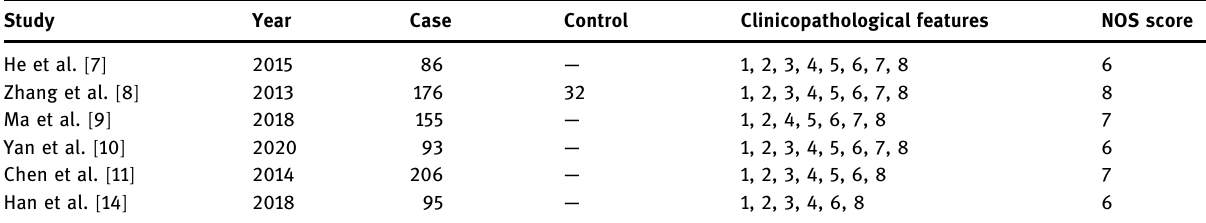
Table 1: Characteristics of included studies